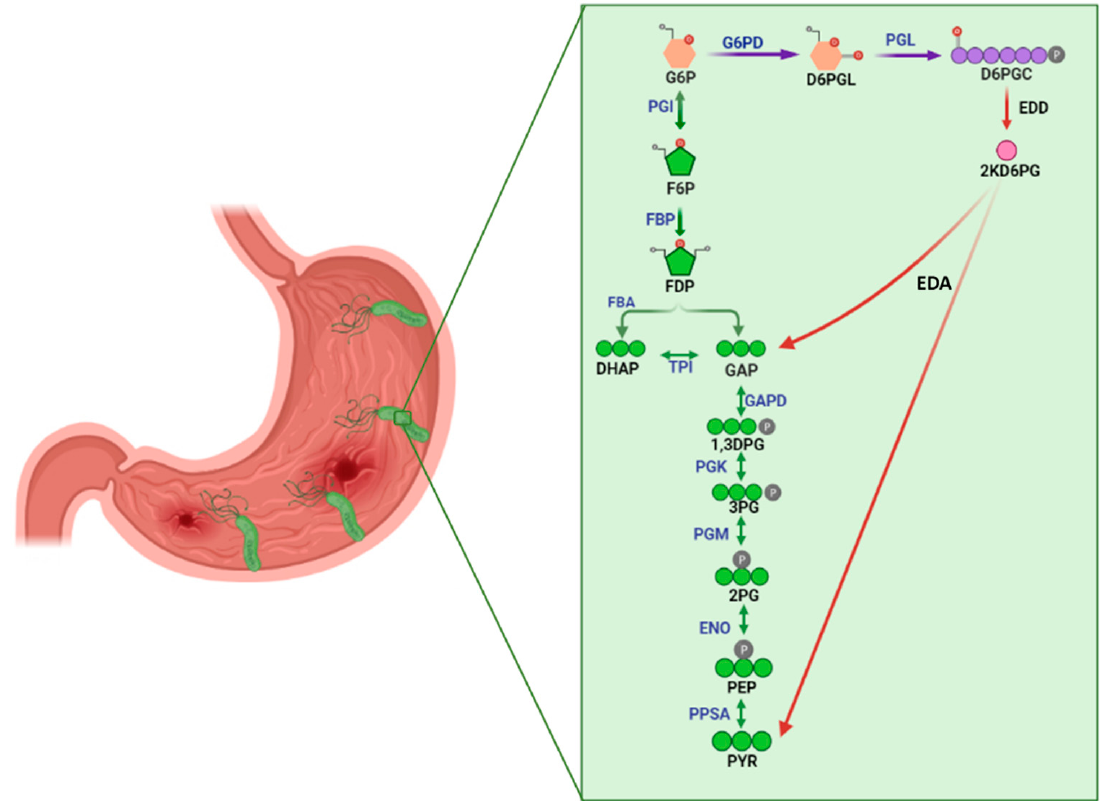
Figure 1. A graphical illustration of the central metabolism subsystem in the reconstructed network. The lilac arrows show the oxidative phase of the pentose phosphate pathway. The Entner–Doudoroff pathway is shown with red arrows, where glyceraldehyde-3-phosphate and pyruvate are obtained, and glycolysis is shown with green arrows. Metabolites are glucose 6 phosphate (G6P), fructose-6-phosphate (F6P), dihydroxyacetone phosphate (DHAP), glyceraldehyde-3-phosphate (GAP), 1,3-diphosphoglycerate (1,3DPG), 3-phosphoglycerate (3PG), 2-phosphoglycerate (2PG), phosphoenolpyruvate (PEP), pyruvate (PYR), 6-phosphogluconolactone (D6PGL), 6-phosphogluconate (D6PGC), 2-keto-3-deoxy-6-phosphogluconate (2KD6PG). Enzymes are phosphoglucose isomerase (PGI); fructose-1,6-bisphosphatase (FBP); fructose-1,6-bisphosphate aldolase (FBA); triosephosphate isomerase (TPI); glyceraldehyde-3-phosphate dehydrogenase (GAPD); phosphoglycerate kinase (PGK); phosphoglycerate mutase (PGM); enolase (ENO); phosphoenolpyruvate synthase (PPSA); glucose-6-phosphate dehydrogenase (G6PD); 6-phosphogluconolactonase (6PGL); 6-phosphogluconate dehydratase (EDD); and 2-keto-3-deoxy-6-phosphogluconate aldolase (EDA).